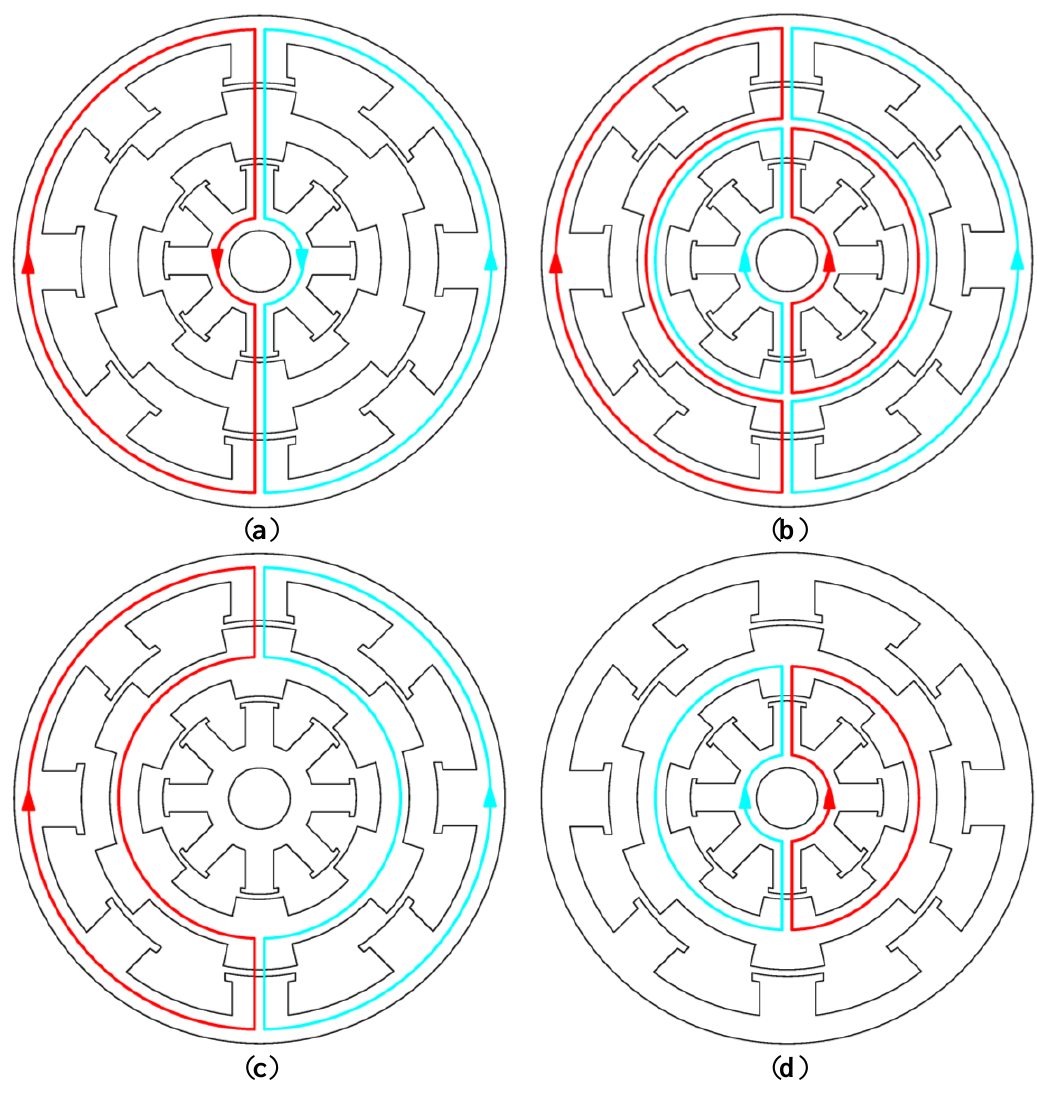
Figure 5. Different magnetic circuits of SRDRM: ( a ) Magnetic circuit in series; ( b ) Magnetic circuit in parallel; ( c ) Stator winding works alone; ( d ) Inner rotor winding works